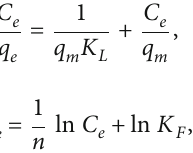
O nanoparticles and MOF/NH 3 4